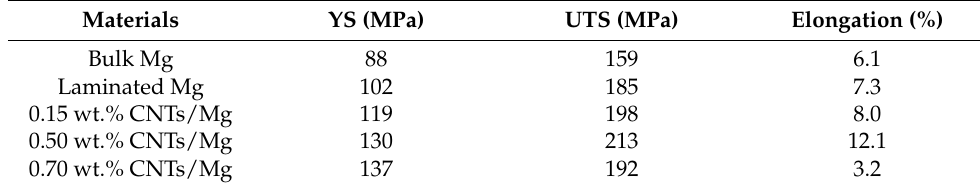
Figure 4. Engineering stress-strain curves of bulk Mg, laminated Mg and CNTs/Mg composites. Table 2. Mechanical properties of Mg and laminated CNTs/Mg composite.